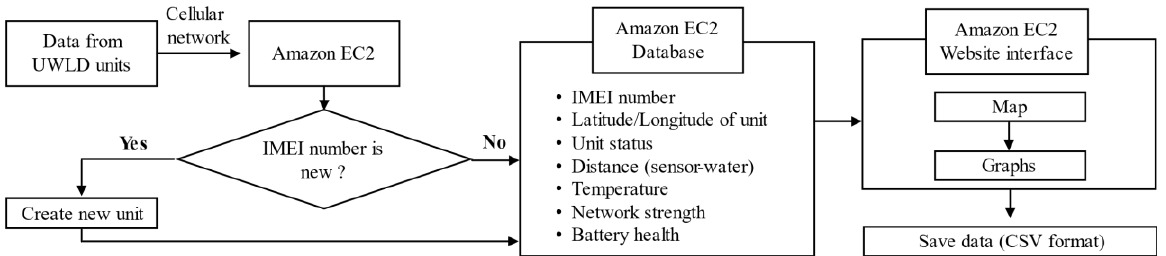
Figure 3. Flow chart (Programming layout) of the data processing of the UWLD system.